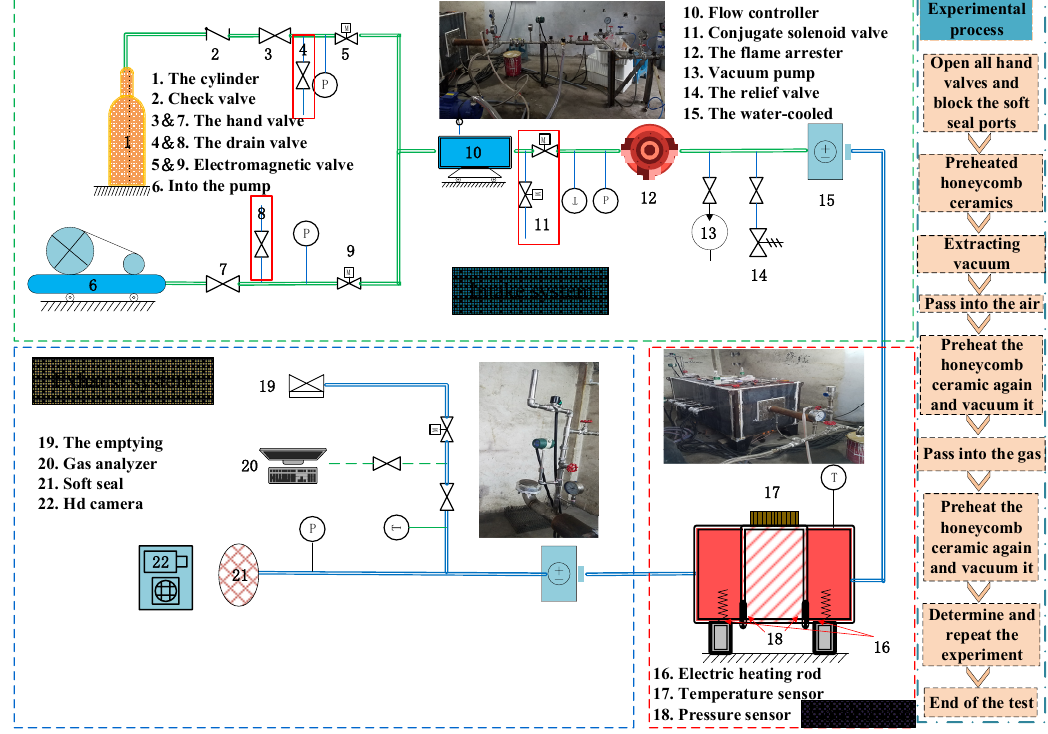
Figure 3. Experimental equipment and process.